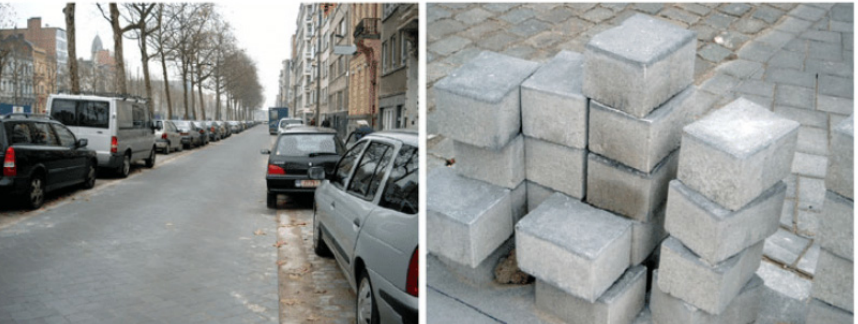
Figure 6. View of a parking lane with a photocatalytic paving stone in Antwerp [165].